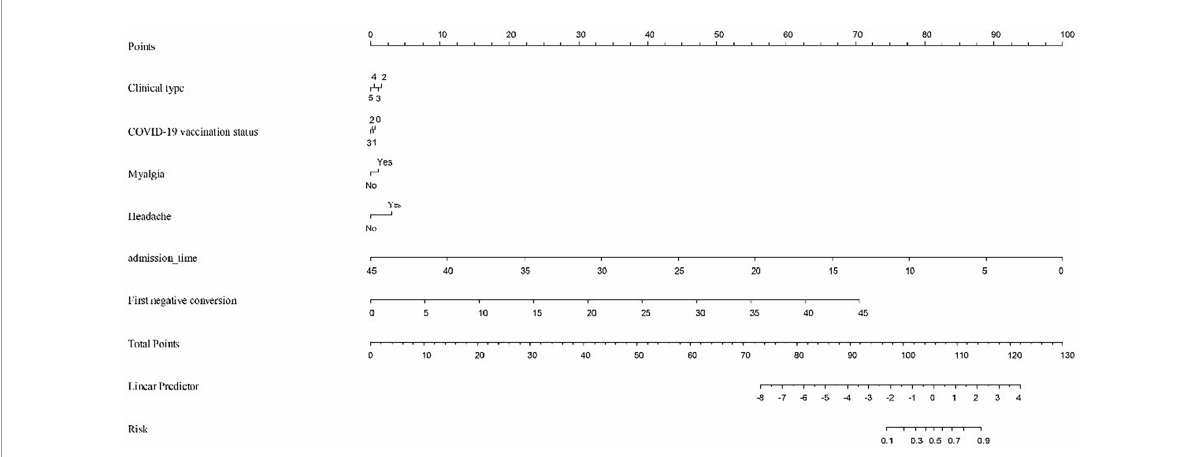
FIGURE1 To calculate predicted occurrence, locate an individual’s value on each independent variable axis, and then draw a straight line upward “Points” row to obtain the points for each variable. Next, locate the sum of these points on the total points axis, and draw a line downward to the “Risk” row to obtain the probability of re-testing positivity within 30 days. Clinical type: 2—Severe, 3—General, 4—Mild, and 5—Asymptomatic. COVID-19 vaccine status: 0—Unvaccinated, 1—Partially vaccinated, 2—Primarily vaccinated, and 3—Completely